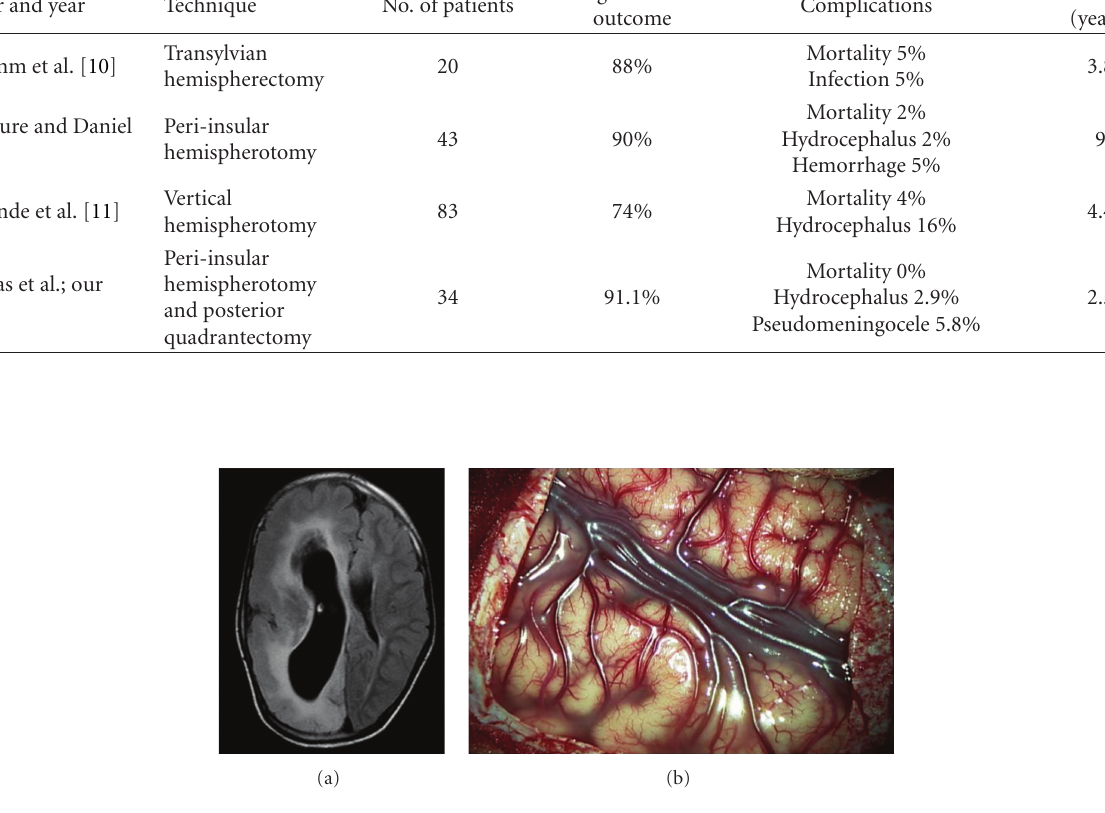
Figure 5: (a) T2W Axial Flair MRI Image of a patient with right hemimegalencephaly showing an enlarged right hemisphere with thickened cortical mantle, distorted ventricular anatomy, and widened gyri, (b) intraoperative photograph.